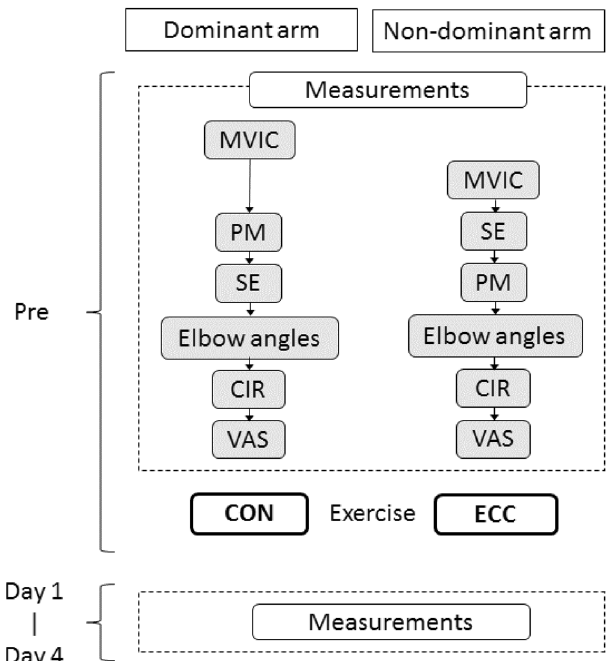
Figure 1. Schematic representation of the study protocol. The assessments of muscle damage markers and muscle hardness in the dominant and non-dominant arm were conducted sequentially as shown in the “Measurements” that consisted of maximal voluntary isometric contraction force (MVIC), push-in meter (PM), strain elastography (SE), relaxed, extended and flexed elbow angle (Elbow angles), upper arm circumference (CIR) and visual analog scale (VAS) for muscle soreness, before (Pre) and 1–4 days after exercise (Day 1- Day 4). After the Pre assessments, concentric (CON) and eccentric contractions (ECC) were performed by the dominant and non-dominant arm, respectively.